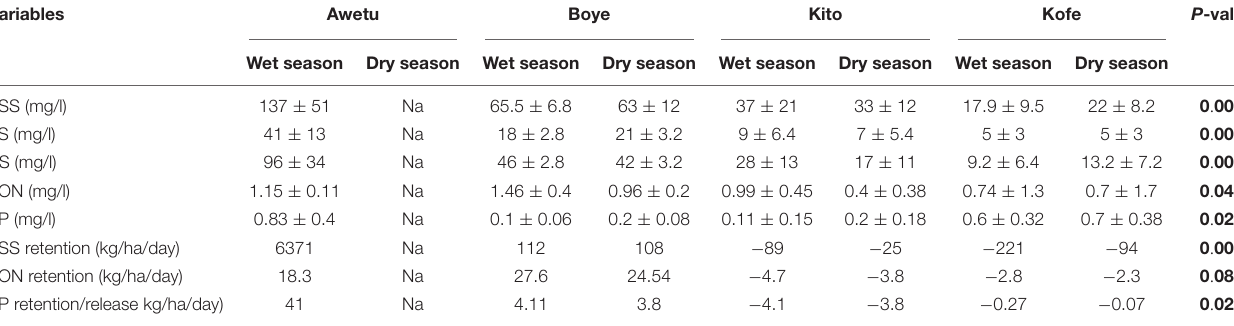
TABLE 2 | Sediment and nutrients retention/release capacity of wetlands in the Gilgel Gibe I watershed.